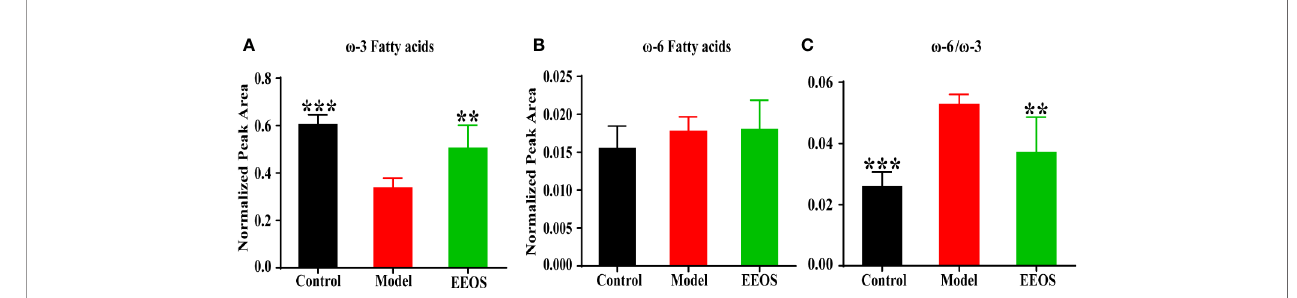
FIGURE 5 | Changes in the composition of polyunsaturated fatty acids esteri fi ed by glycerophospholipids. (A) Differences in w -3 fatty acids between the three groups. The w -3 fatty acids in model group was signi fi cantly lower than that in control group and EEOS group; (B) w -6 fatty acids no difference in w -6 fatty acids between the three groups; (C) The ratio of w -6 fatty acid chains to w -3 fatty acid chains in glycerophospholipids was signi fi cantly increased in model groups compared with the control group and EEOS group. Data are expressed as mean ± SD. ** P < 0.01, *** P < 0.001 vs. the model group.